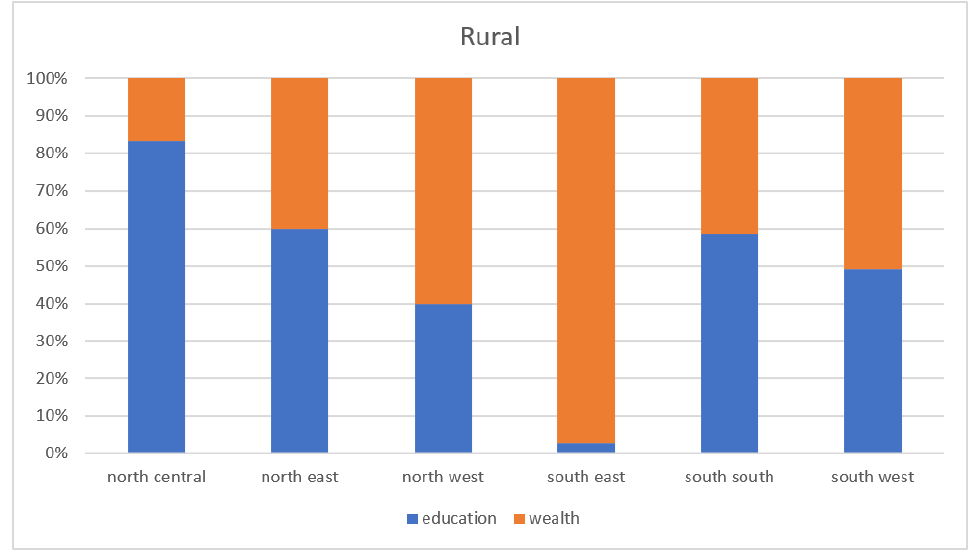
Figure 3. Blinder – Oaxaca decomposition for the change in the prevalence of zero-dose children over Figure 3. Blinder–Oaxaca decomposition for the change in the prevalence of zero-dose children time. over